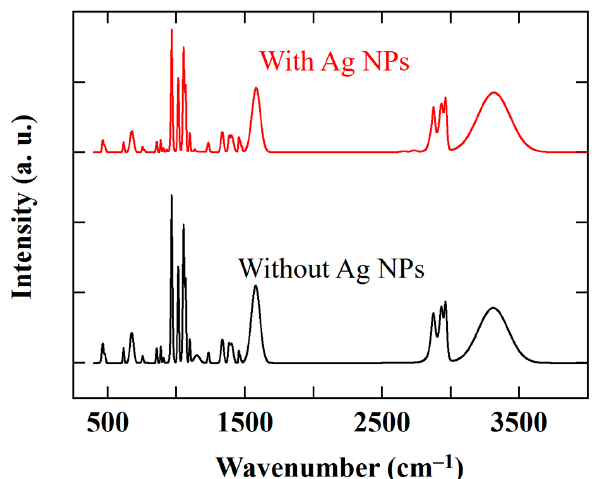
Figure 2. FTIR absorption spectrum of ZnO precursor solution without and with 10% Ag NPs.